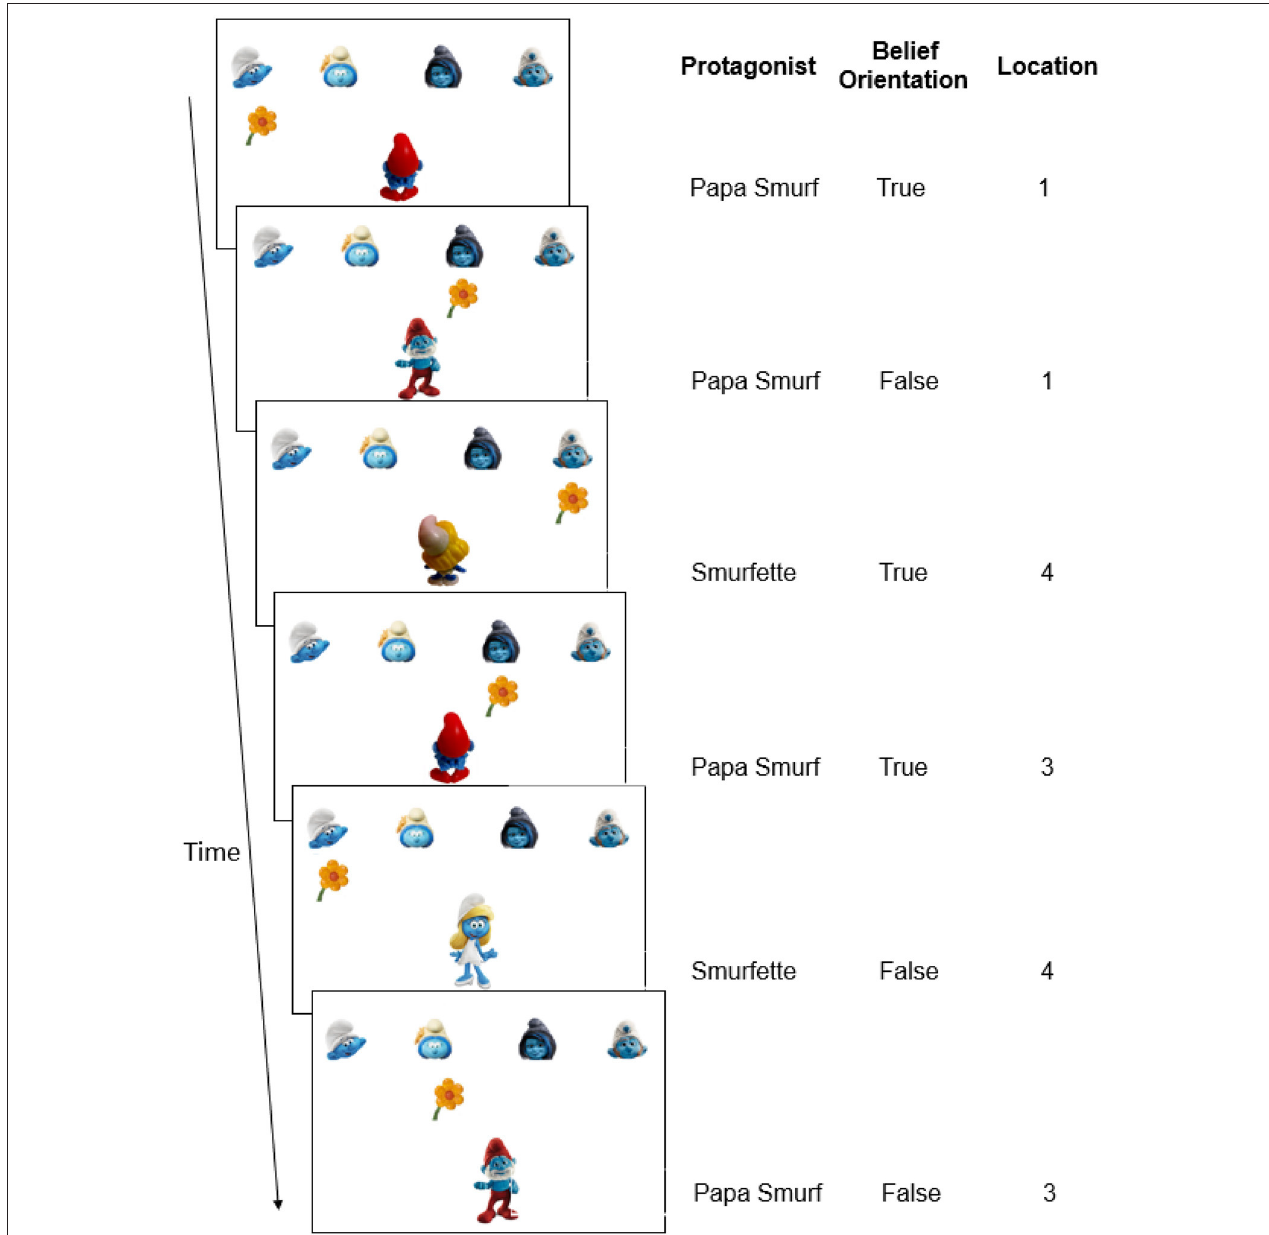
FIGURE 1 | Schematic example of the belief SRT task in Experiment 1. (Left) On each trial, participants had to report where the flower was located from the protagonists’ perspective (pressing “1”–“4” on the keyboard, corresponding to the leftmost to the rightmost location). When the protagonist was oriented toward the flowers (true belief), the correct answer is the flower’s real location on the screen. When the protagonist was oriented away from the flowers (false belief), the correct answer is the location of the flower when the protagonist was previously oriented toward to the flowers. Consequently, in this example, the flower’s location from the protagonists’ perspective is 1-1-4-3-4-3 (i.e., the correct response). (Right) The belief-related sequence (first six trials only) with dimensions of the protagonists’ identities (Papa Smurf or Smurfette), protagonists’ belief orientations (true or false) and flowers’ locations from the protagonist’s perspective (1–4). In the full standard sequence which consisted of eight trials in Experiment 1, each location, protagonist identity and belief orientation was equally frequent (see Table 1 and Supplementary Presentation 1 ). No other sequences were built in.